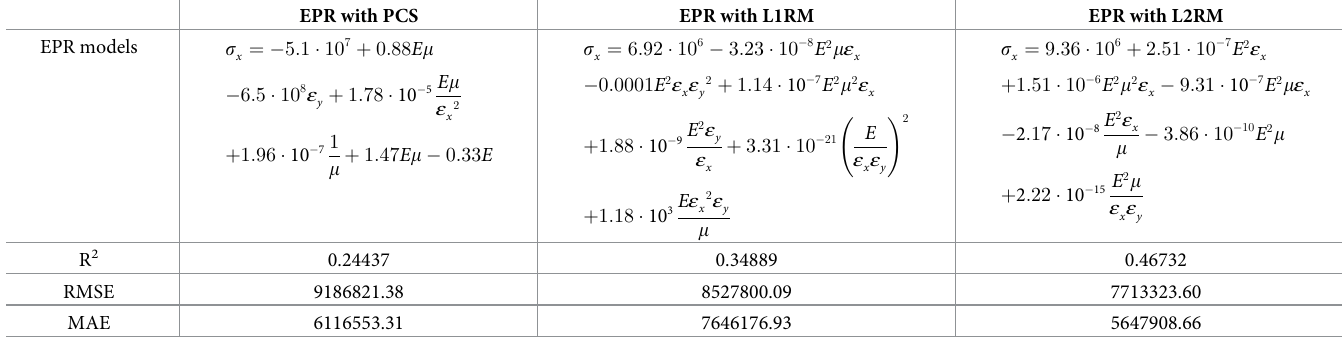
performance, the prediction performance (generalization ability) is discussed (Table 7) when the number of terms is 6 (m = 6). As shown in Table 7, the prediction performances (generalization ability) of the three EPR models presented three indicators. EPR with L1RM offers the best performance; EPR with L2RM ranks second. However, its performance is close to EPR with L1RM. EPR with PCS is Table 5. Prediction performance of 3 EPR models in dataset 3. EPR with PCS EPR with L1RM EPR with L2RM EPR